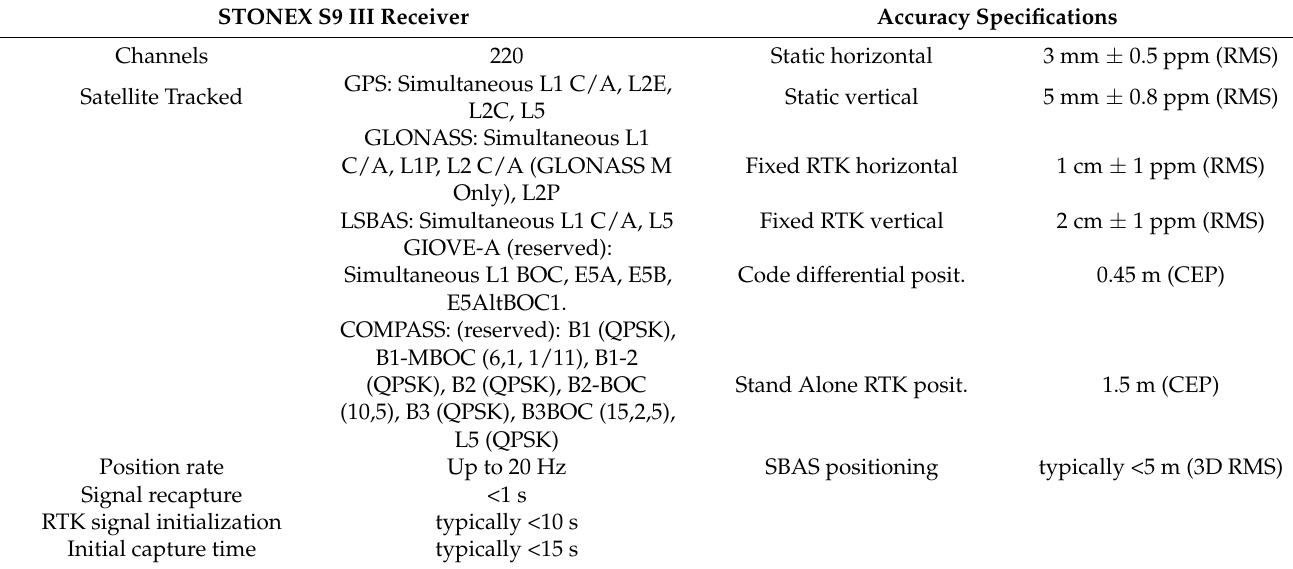
Table A2. Main characteristic of ® STONEX S9III system.